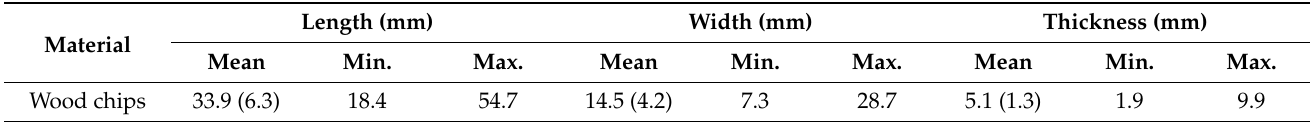
Table 1. Dimensions of wood chips.